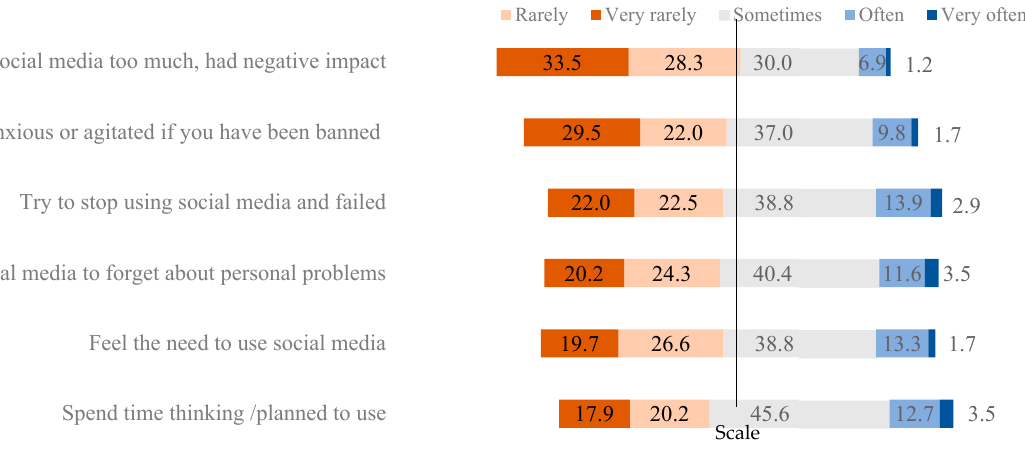
Figure 1. Social media addiction characteristics among Vietnamese youths.